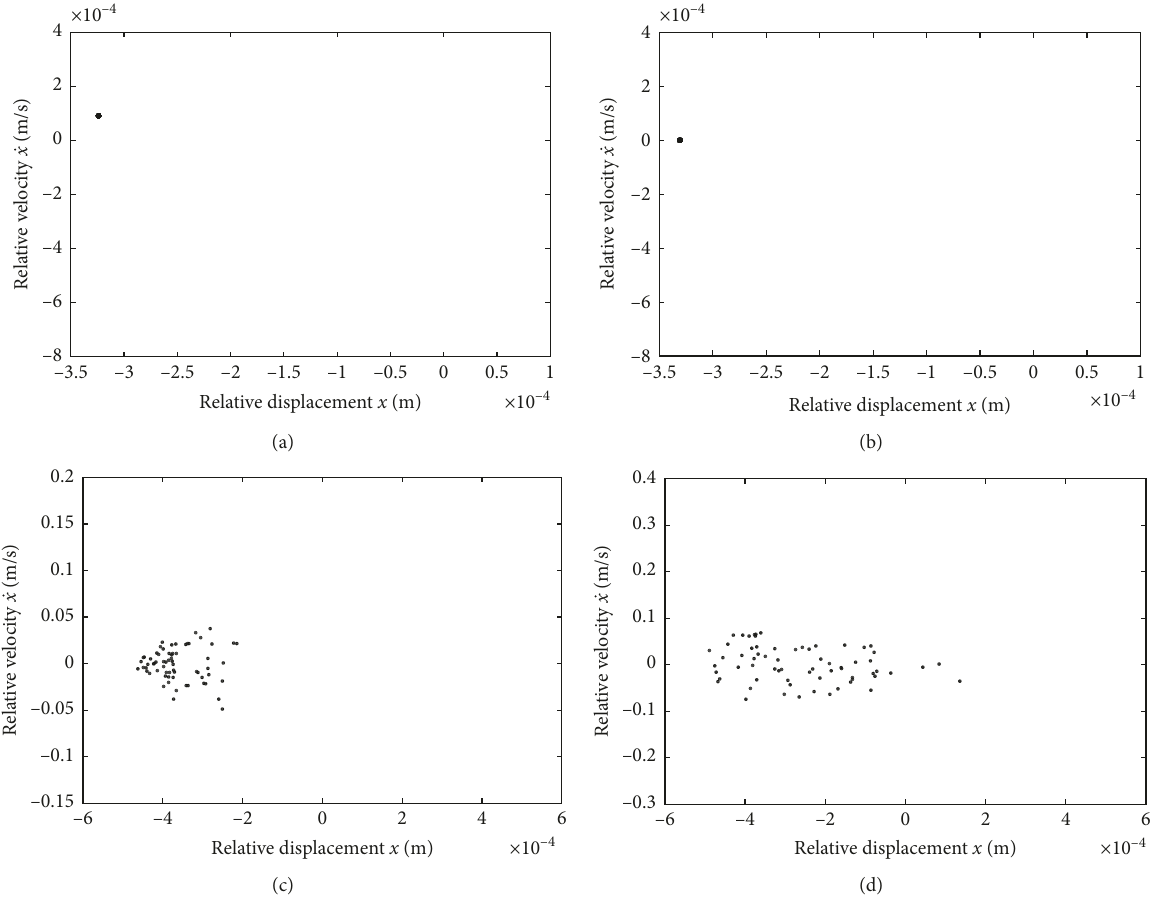
Figure 17: Poincar´e portrait of 2-DOF nine-bar mechanism for different driving speeds: (a) ω � − 1 . 5 π ( rad / s ) , ω (b) ω 1